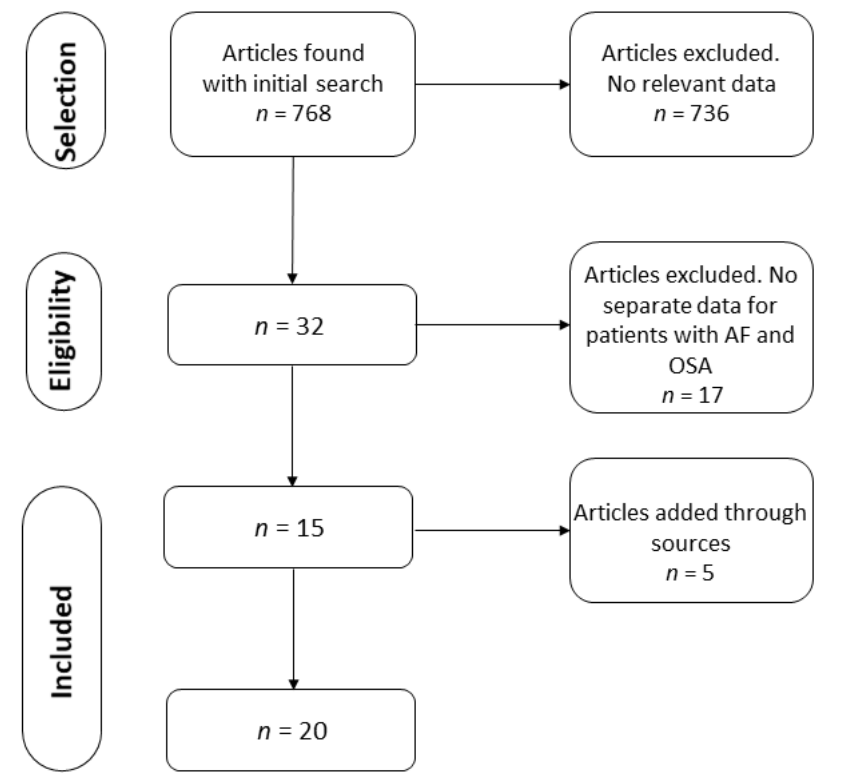
Figure 1. PRISMA flow chart of the article selection process. AF = Atrial fibrillation. OSA = Obstructive Sleep Apnea. Table 1. Patients’ characteristics.